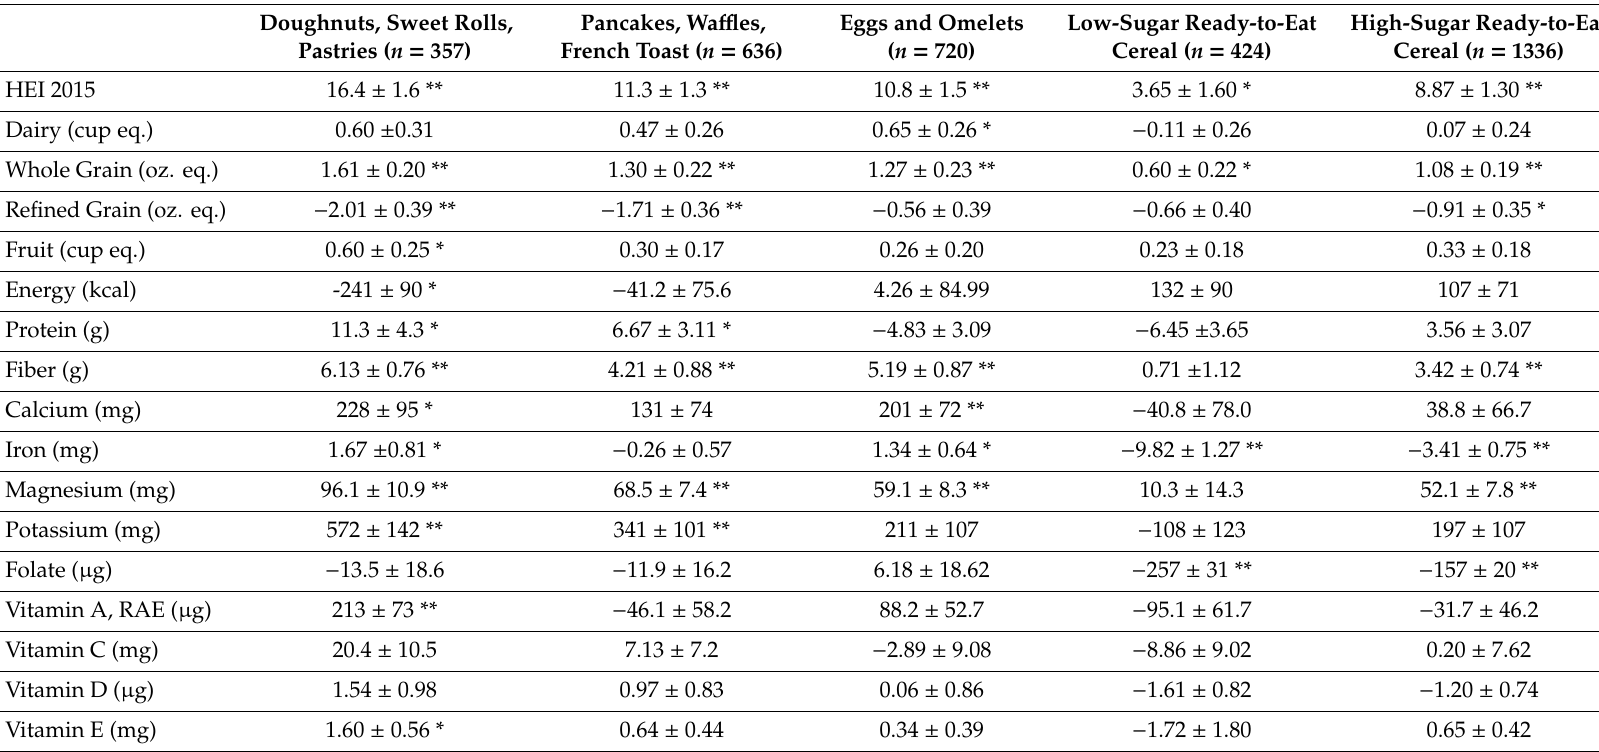
Table 3. Di ff erences in diet quality and intake of select food groups and nutrients for children 2–18 years of age (gender-combined), who consumed oatmeal breakfasts compared to those who consumed other common breakfasts, NHANES